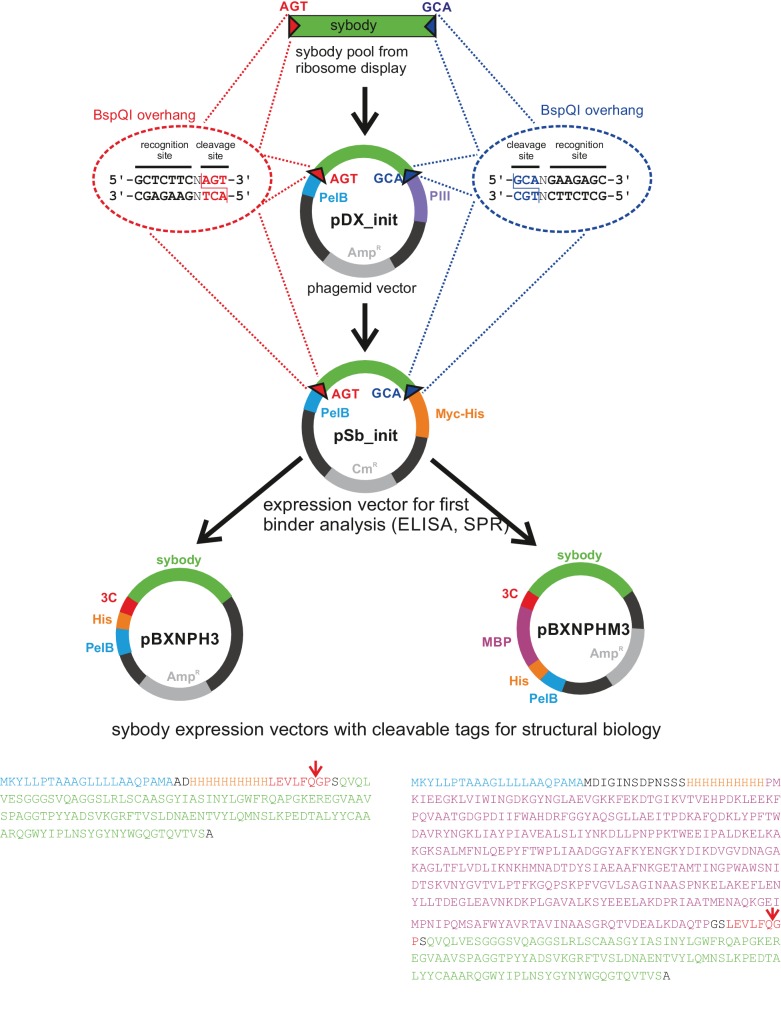
FX cloning vector series for phage display and purification of sybodies and nanobodies.Sybody pools from ribosome display (or nanobodies from immunized camelids) are amplified with primers containing restriction sites of Type IIS enzyme BspQI (isoschizomer of SapI) to generate AGT and GCA overhangs. BspQI restriction sites generating the same overhangs were introduced into the backbones of vector pDX_init for phage display and pSb_init for periplasmatic expression and attachment of Myc- and His-tag. Note that in pDX_init and pSb_init the BspQI restriction sites are part of the sybody open reading frame. Finally, sybodies/nanobodies are sub-cloned from pSb_init to the destiny vectors pBXNPH3 or pBXNPHM3 for periplasmic expression. Tag-less sybodies/nanobodies for structural biology purposes can be obtained by 3C protease cleavage. Importantly, the vector series permits for PCR-free subcloning once the sybodies have been inserted into phage display vector pDX_init. The vectors were made available through Addgene (for Addgene IDs, see Table 3).